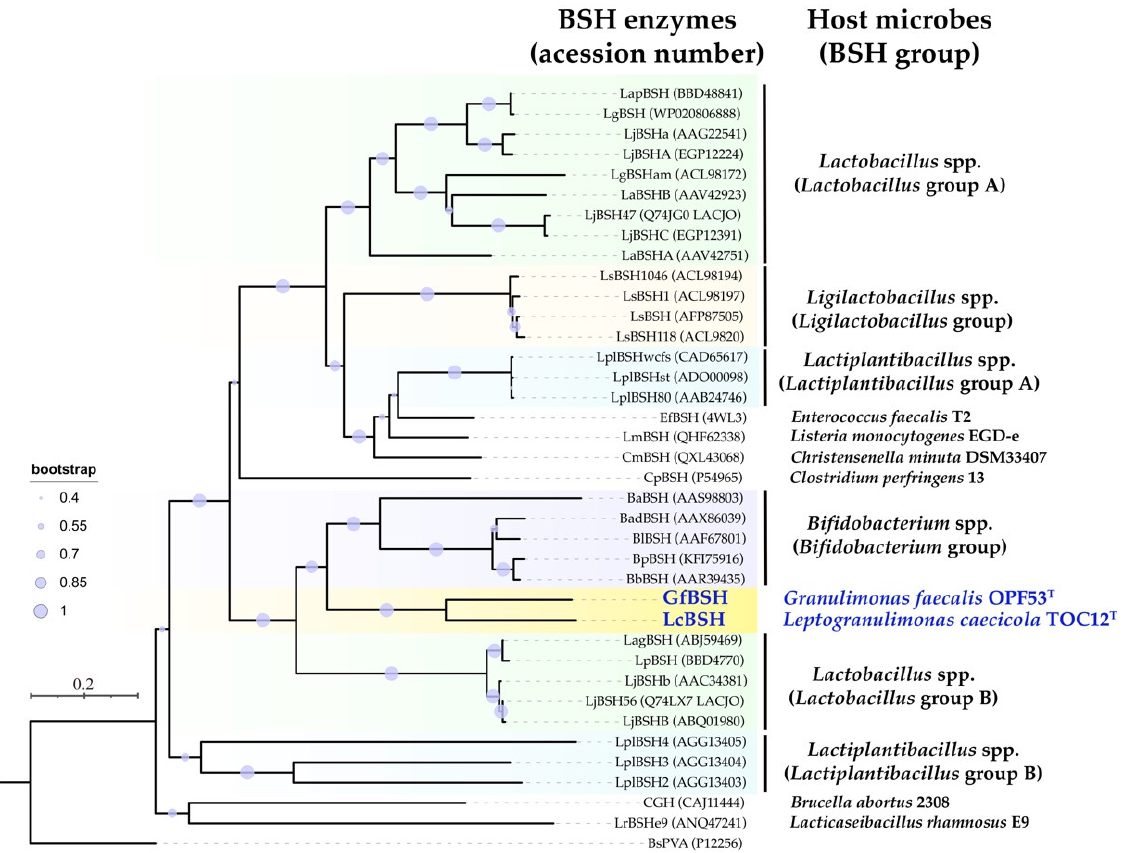
Figure 5. Phylogenetic analysis of LcBSH and GfBSH. Amino acid sequences of LcBSH and GfBSH proteins were aligned with previously identified bile salt hydrolases (BSHs). The phylogenetic tree was constructed with MEGA X software, using the neighbor-joining method (1000 bootstrap replications) [52]. The evolutionary distances were computed using the Poisson correction method and are in the units of the number of amino acid substitutions per site. The phylogenetic tree was displayed and customized using the online tool Interactive Tree Of Life (iTOL v6) [53]. Bootstrap values are shown by circle symbols whose size correlates with the bootstrap values. BsPVA from Lysinibacillus sphaericus was used as an